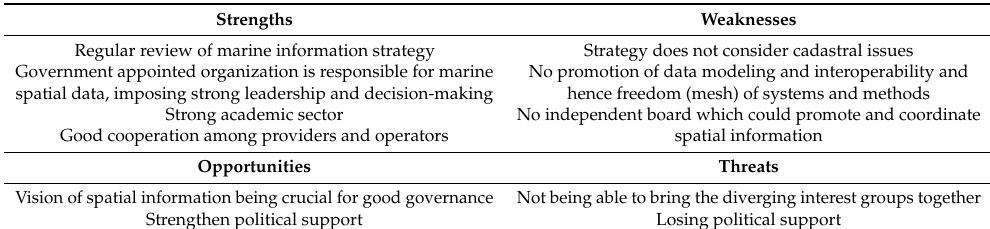
Table 7. SWOT analysis of marine spatial “open” data infrastructures (MSDI) governance. Adapted from reference